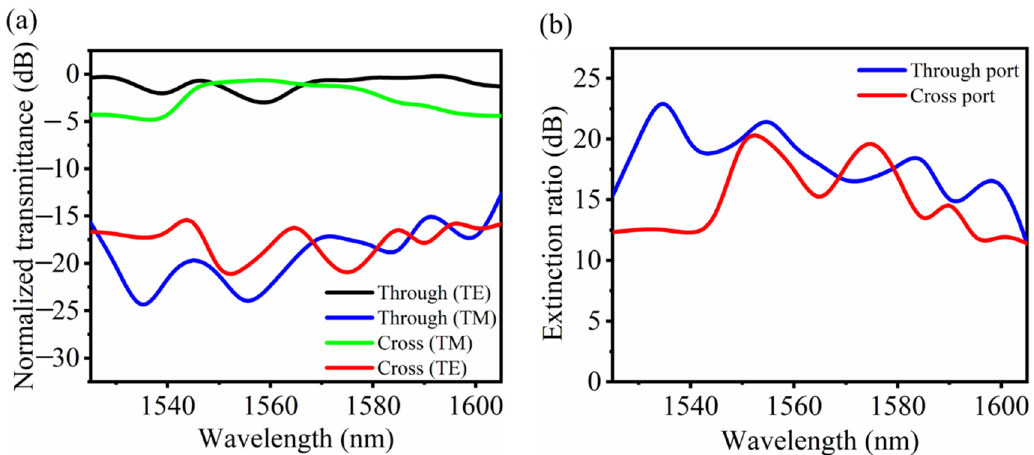
Figure 8. Experimental setup for the device characterization.